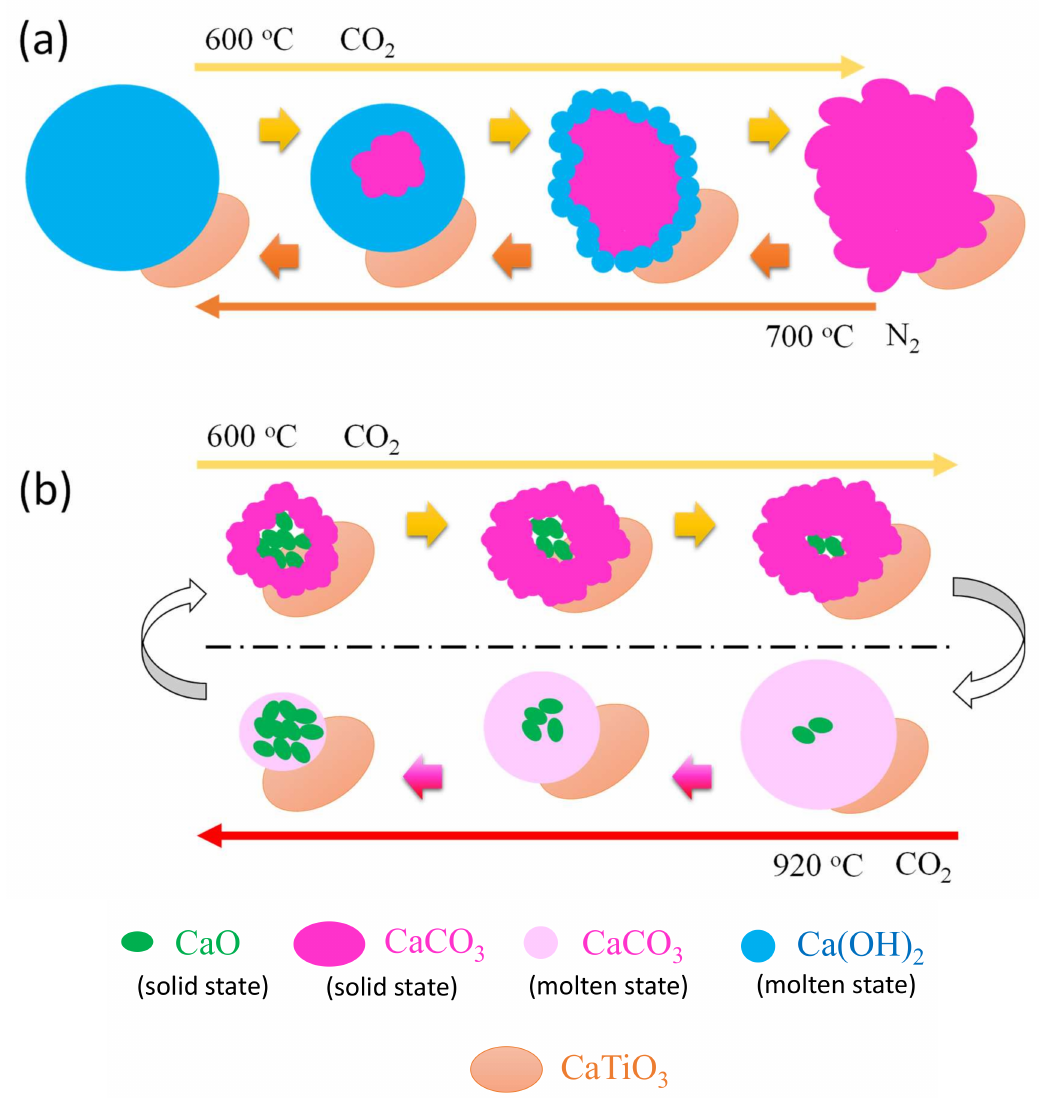
Figure 11. Schematic diagram of CaTi-3 under ( a ) mild regeneration conditions, and ( b ) severe regeneration of multicycle